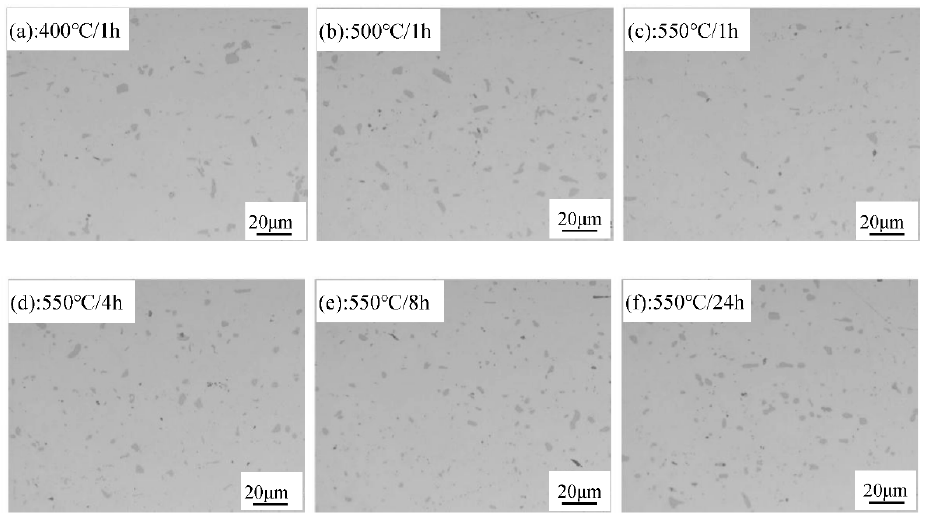
Figure 2. Microstructure of 3104 alloy sheet after various annealing treatments: ( a ) 400 ◦ C / 1 h; ( b ) 500 ◦ C / 1 h; ( c ) 550 ◦ C / 1 h; ( d ) 550 ◦ C / 4 h; ( e ) 550 ◦ C / 8 h; ( f ) 550 ◦ C / 24 h.